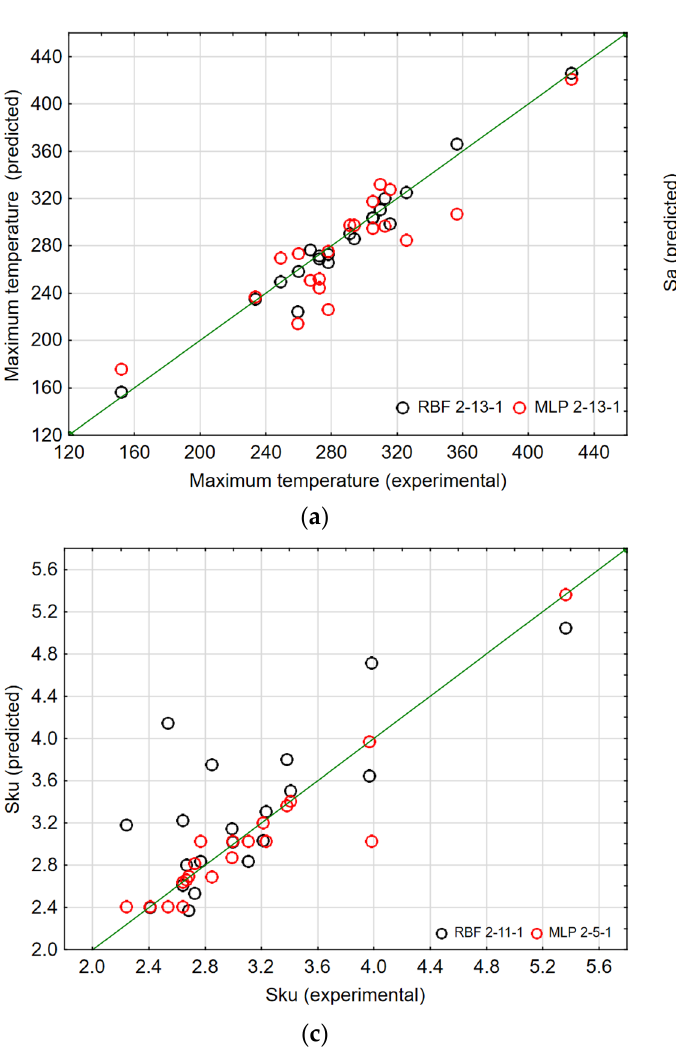
RBF and MPL networks for ( a ) Maximum temperature, ( b ) Sa parameter and ( c ) Sku parameter.